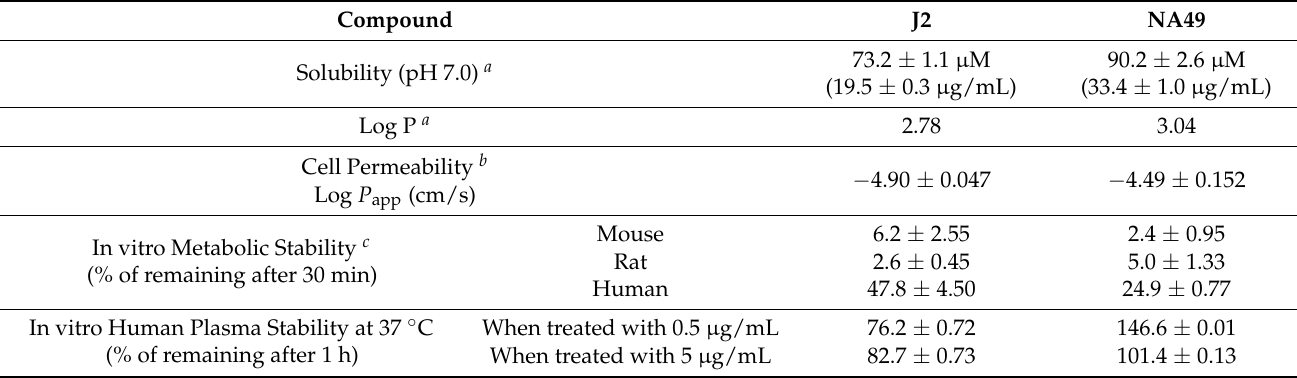
Table 2. Physicochemical properties and stability of J2 and